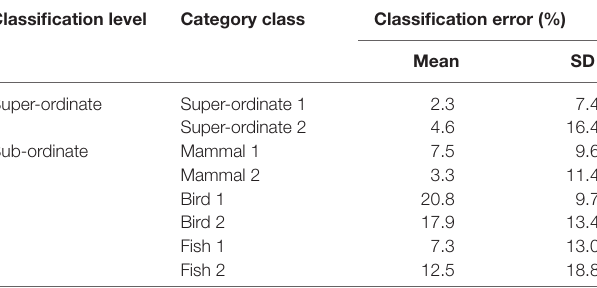
TaBle 1 | Leave-one-participant-out cross-validation test results of specified features for animal classifications. classification